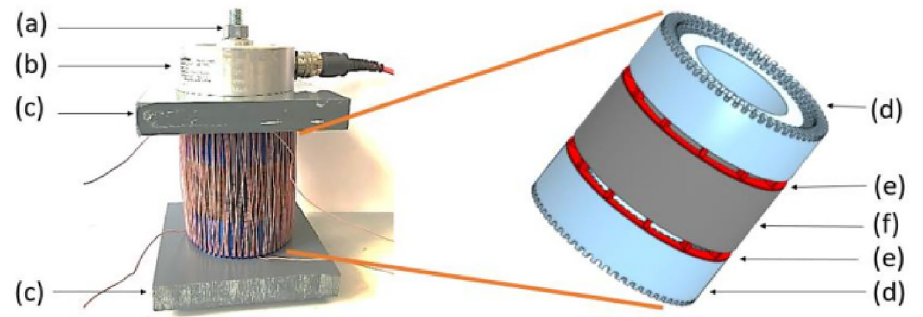
Figure 4. Zoom of the mock-up; ( a ) screw; ( b ) force sensor; ( c ) PVC plate; ( d ) winding frame; ( e ) airvent spacers support; ( f ) laminated magnetic